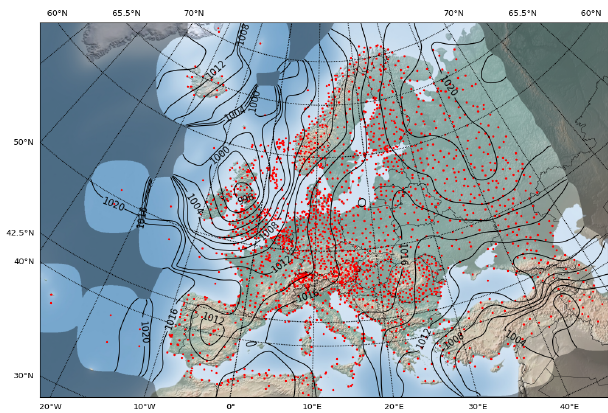
Figure 12. Optimized Barnes interpolation algorithm applied on the Lambert conformal map on a 2048 × 1408 grid with a resolution of 32 grid points per degree along the standard parallels at 42.5 and 65.5 ◦ N, σ = 1 . 0 ◦ and a 4-fold convolution.